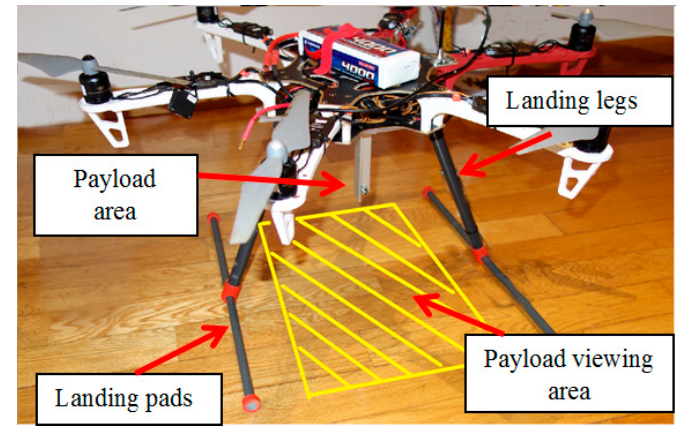
Figure 1. Typical drone landing support.